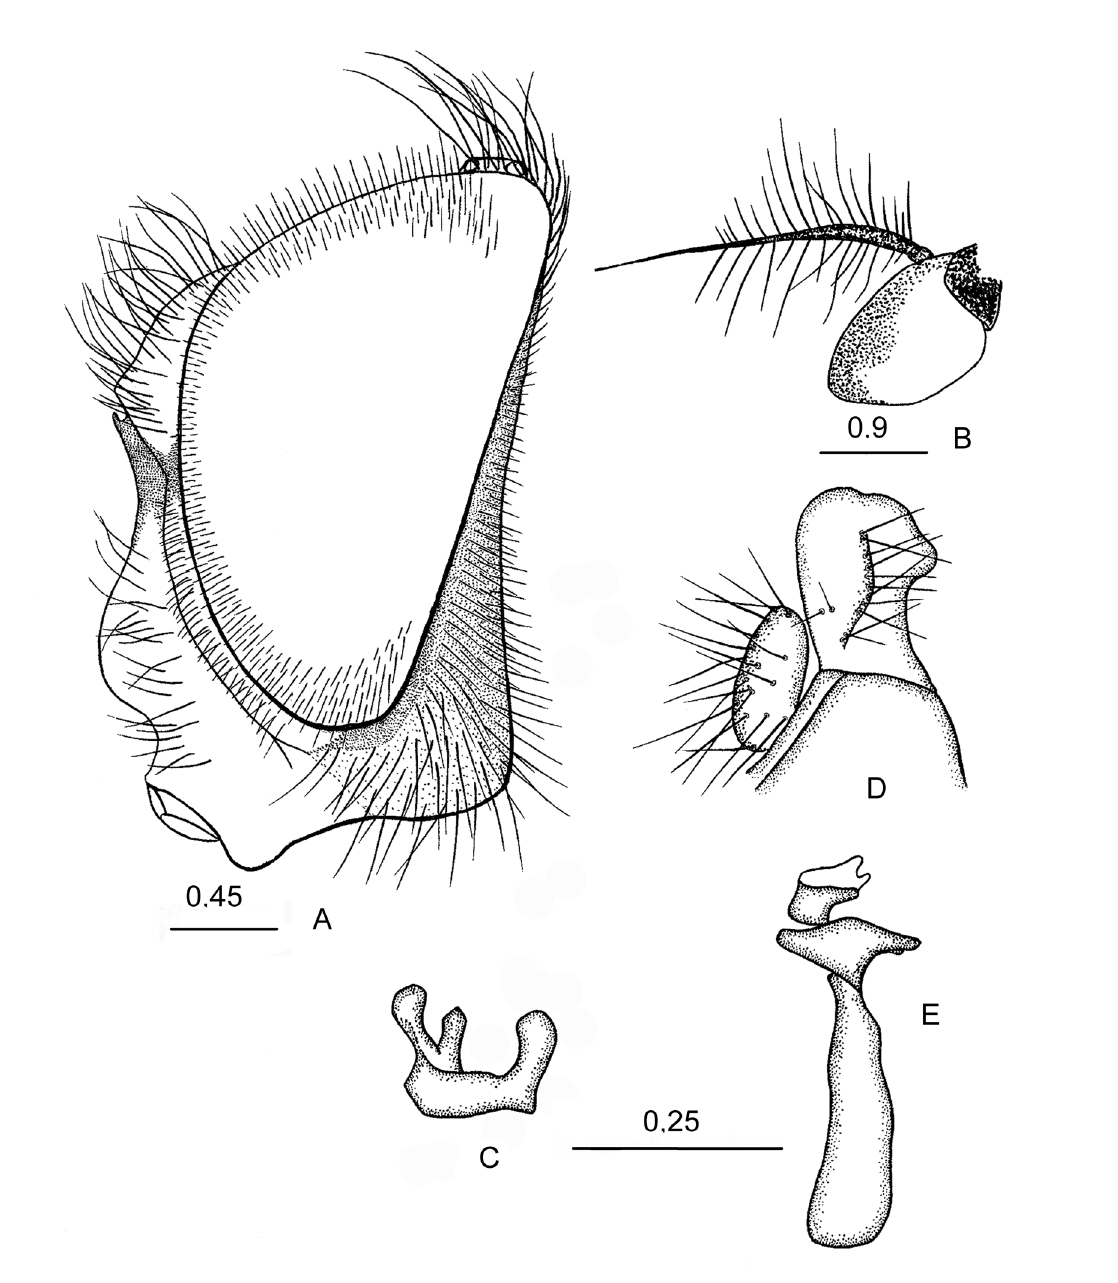
Fig. 31. Cheilosia ( Endoiasimyia ) indiana (Bigot, 1883). A . Head, lateral view. B . Antenna, lateral view of pedicel and basoflagellomere. C . Superior lobe of hypandrium, lateral view. D . Surstylus and gonocercus, lateral view. E . Aedeagus and aedeagal apodeme, lateral view. After Barkalov & Cheng 2004. Scale bars indicated in